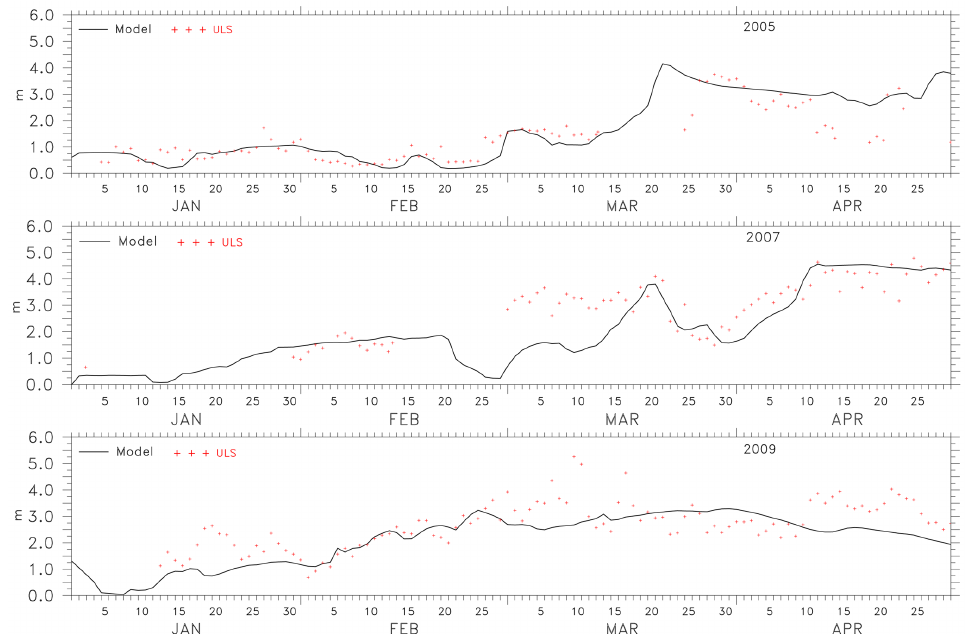
Figure 15. The keel depth computed from the ULS measurement and the M2-estimated values in centimetres for 2005, 2007 and 2009.